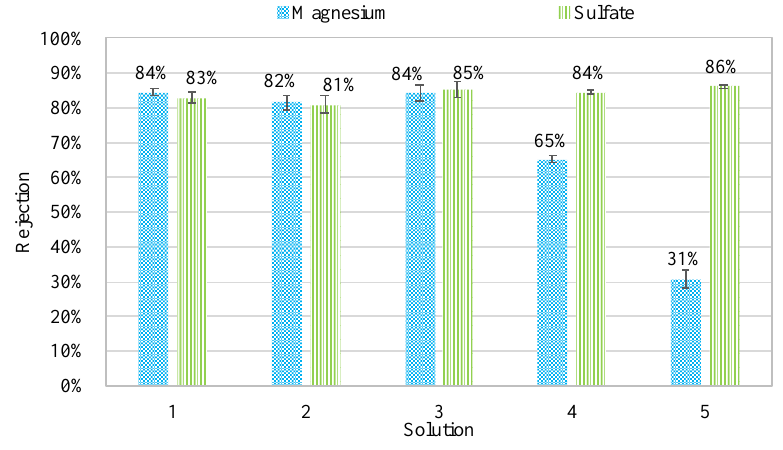
Figure 2. Magnesium and sulfate rejection variations for each solution.